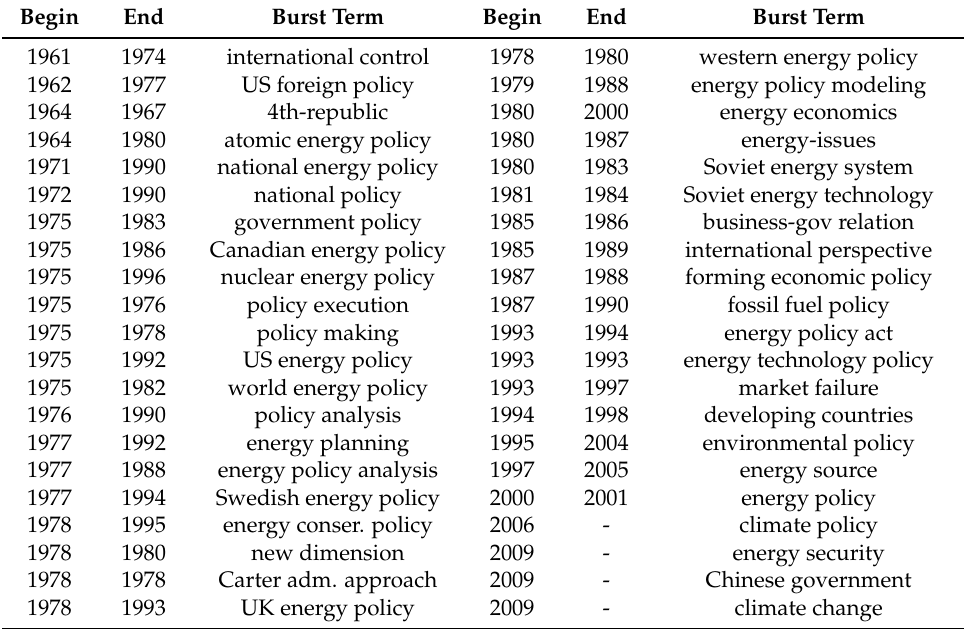
Table 2. Burst terms with time span during